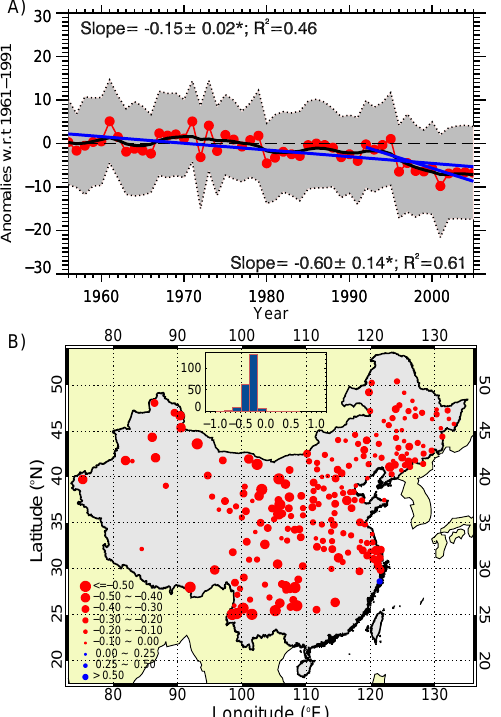
Figure 4. Same as Fig. 3 except for the last date of the near-surface soil freeze. the FD changes. However, changes in LD and DR with ele- vation are not statistically significant in western China (not